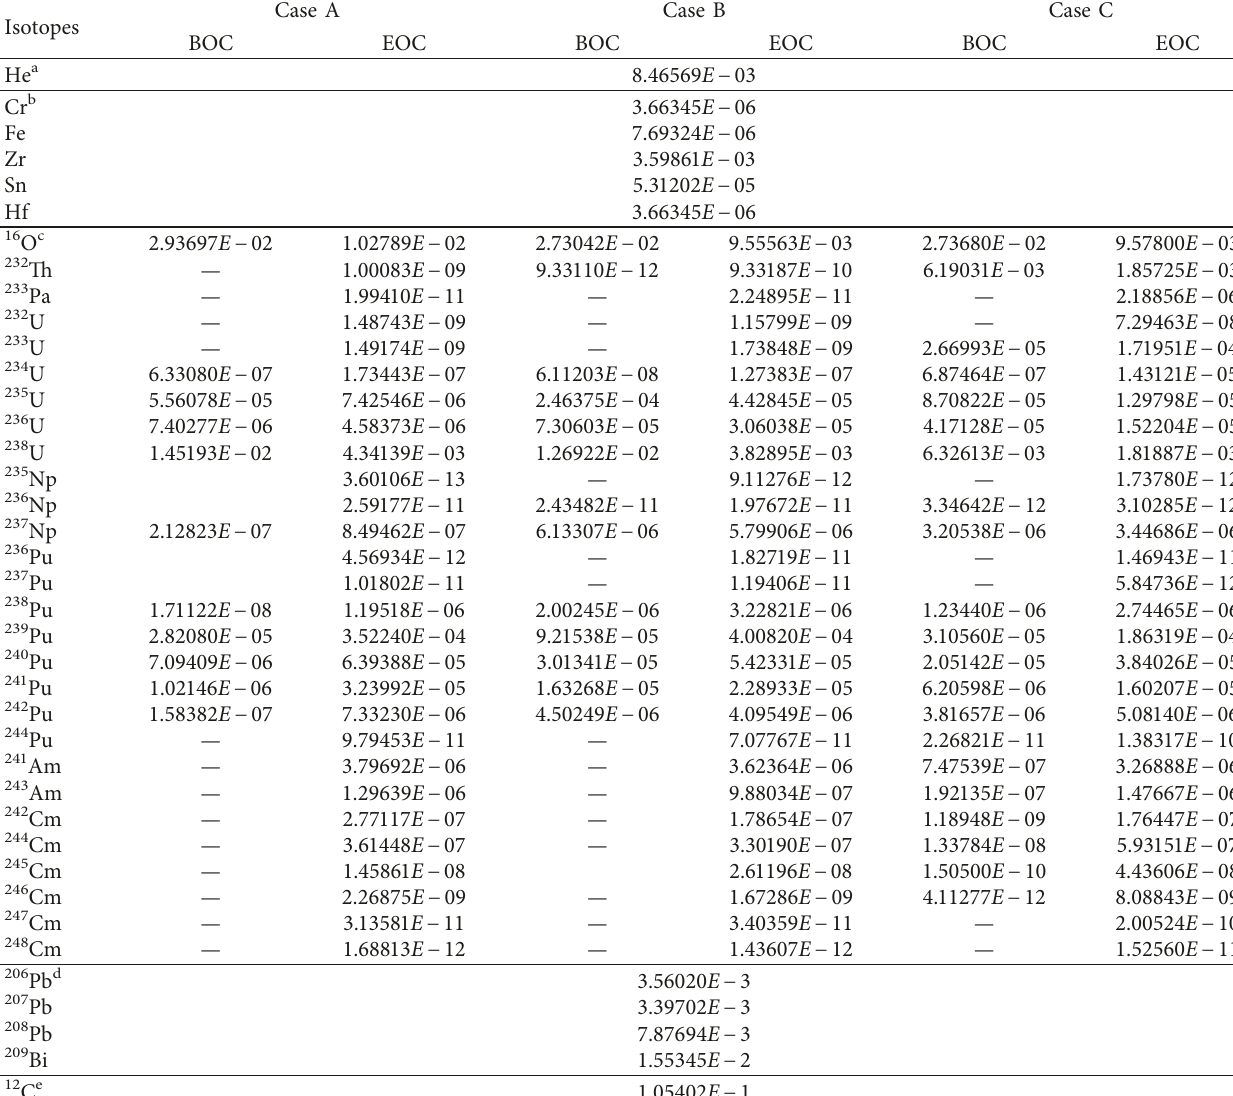
Table 1: Atomic densities of isotopes used in the modified ADS (atoms/(barn · cm)).